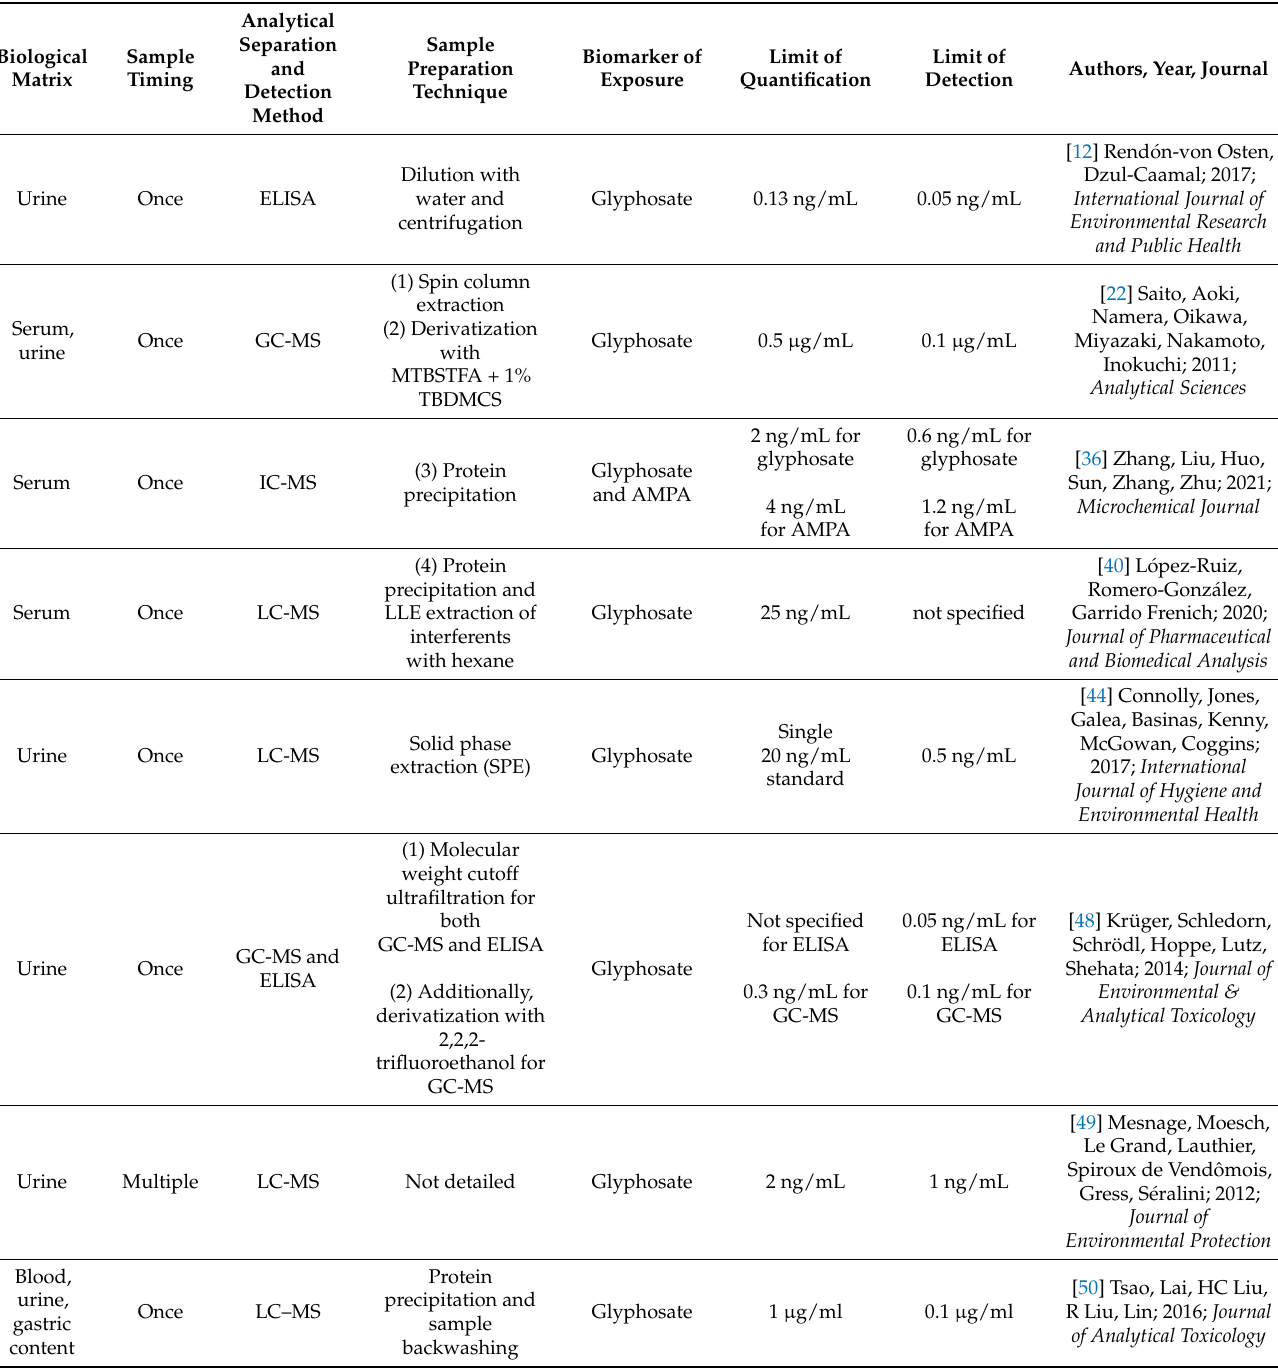
Table 1. Methods described in the scientific literature for biomonitoring glyphosate exposure from human biological